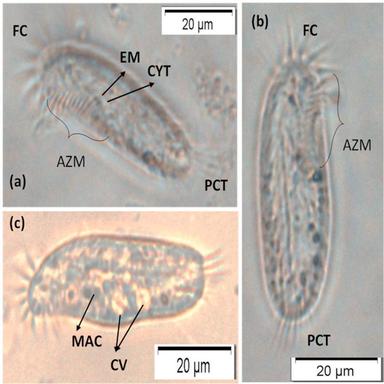
Detailed Image of internal ultrastructure of coral associated ciliate Holosticha sp. (a) Showing sagittal plane view with structures as FC – Frontal cirri, EMelongated membranelle, CYT – Cytostome, PCT- Posterior cilia tuft and AZM – Adoral zone of membranelles (b) Another view of coral associated ciliate Holostichasps. (c) Showing MAC – Macronuclear nodules, CV – Contractile vacoules. Scales included are added from microscopy images.